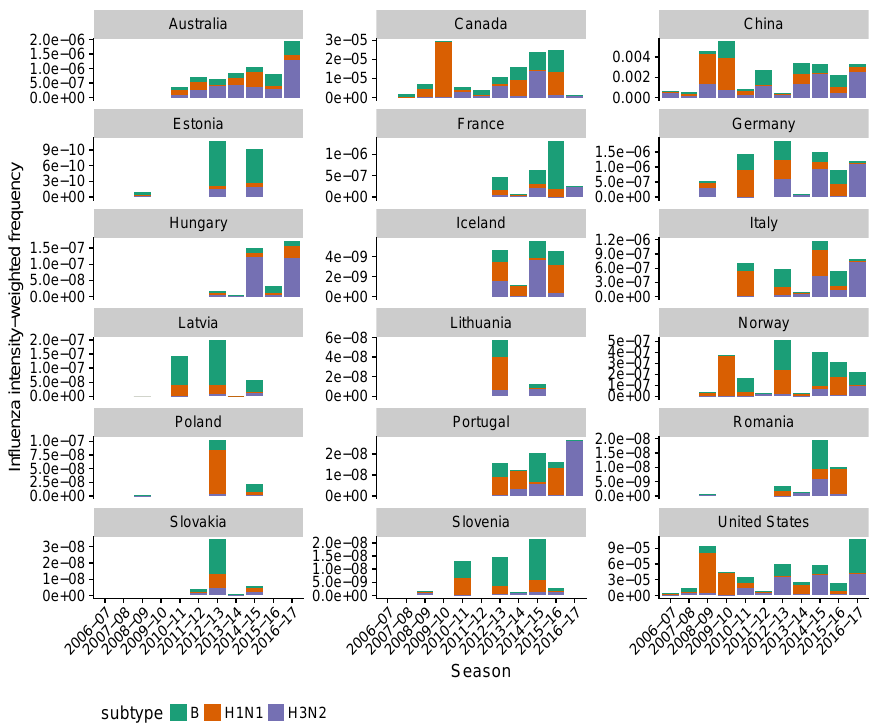
Figure A14. Influenza intensity-weighted seasonal subtype and type frequencies prior to summation for use in country-level analysis (Figures A13 and